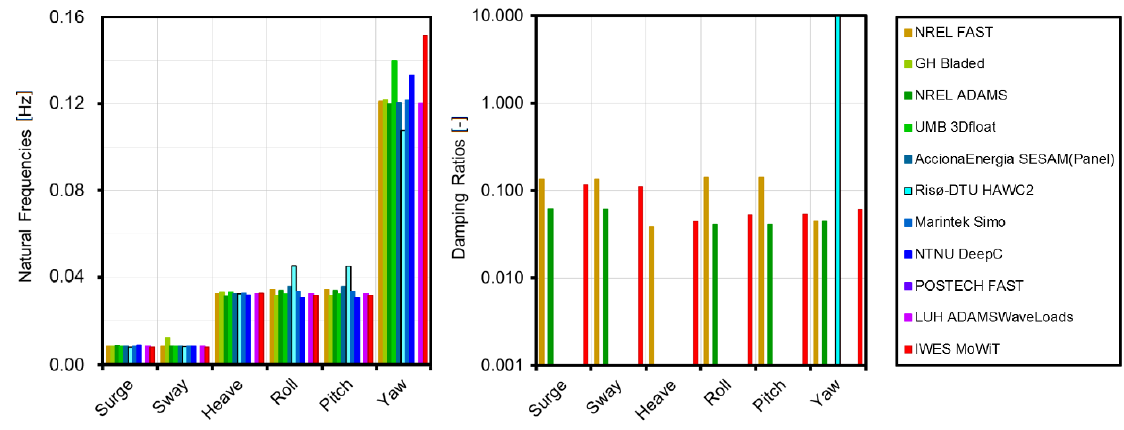
Figure 7. Full-system hydro-elastic natural frequencies and damping